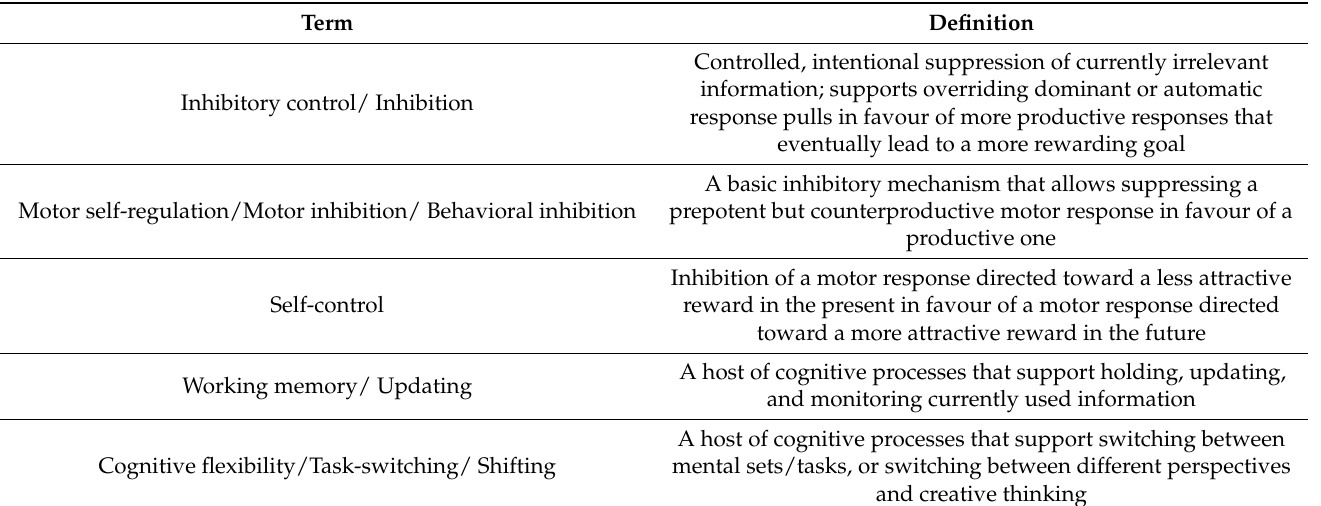
Table 1. Overview of the key terms that were used in this